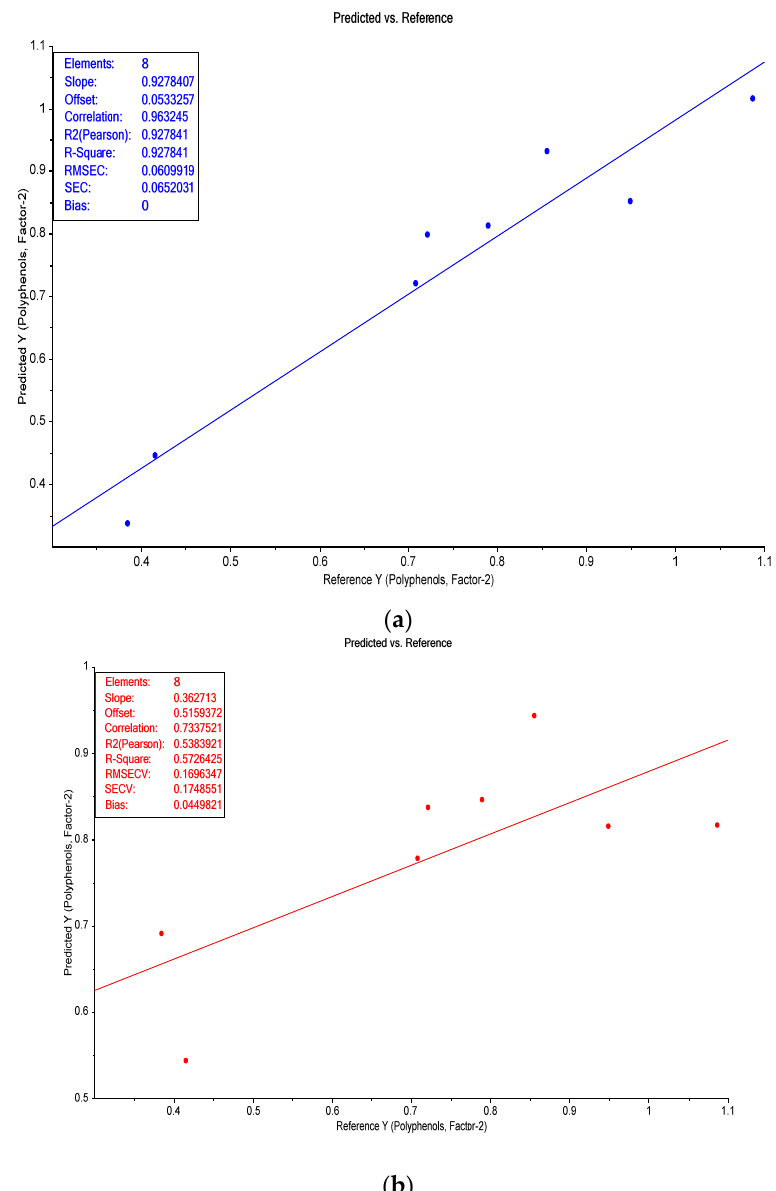
Figure 7. Partial least square (PLS) calibration ( a ) and full cross-validation ( b ) models for total phenolic prediction by using pre-treated standard normal variate (SNV) FTIR spectra—optimum spectral regions selected.